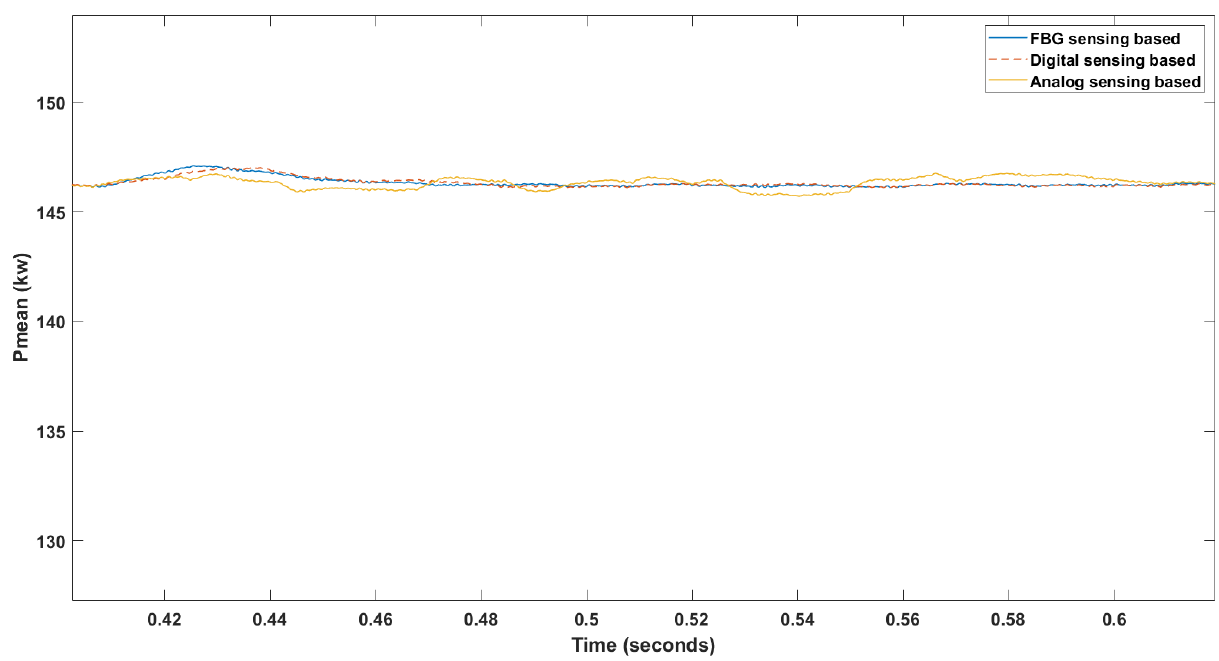
Figure 15. Output metrics at the potential point of PCC output.